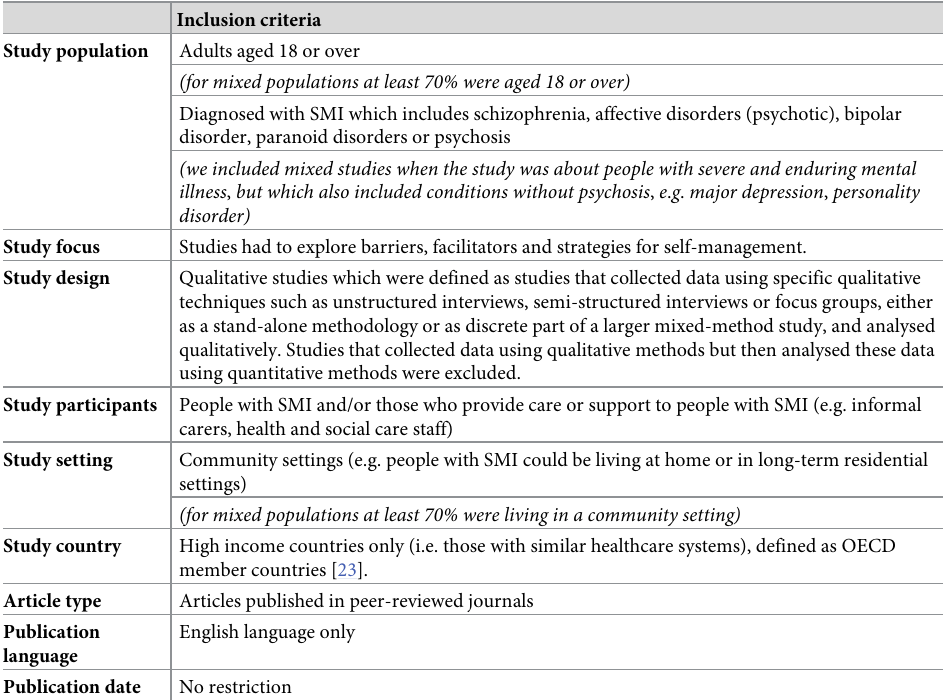
Table 1. Inclusion criteria for qualitative